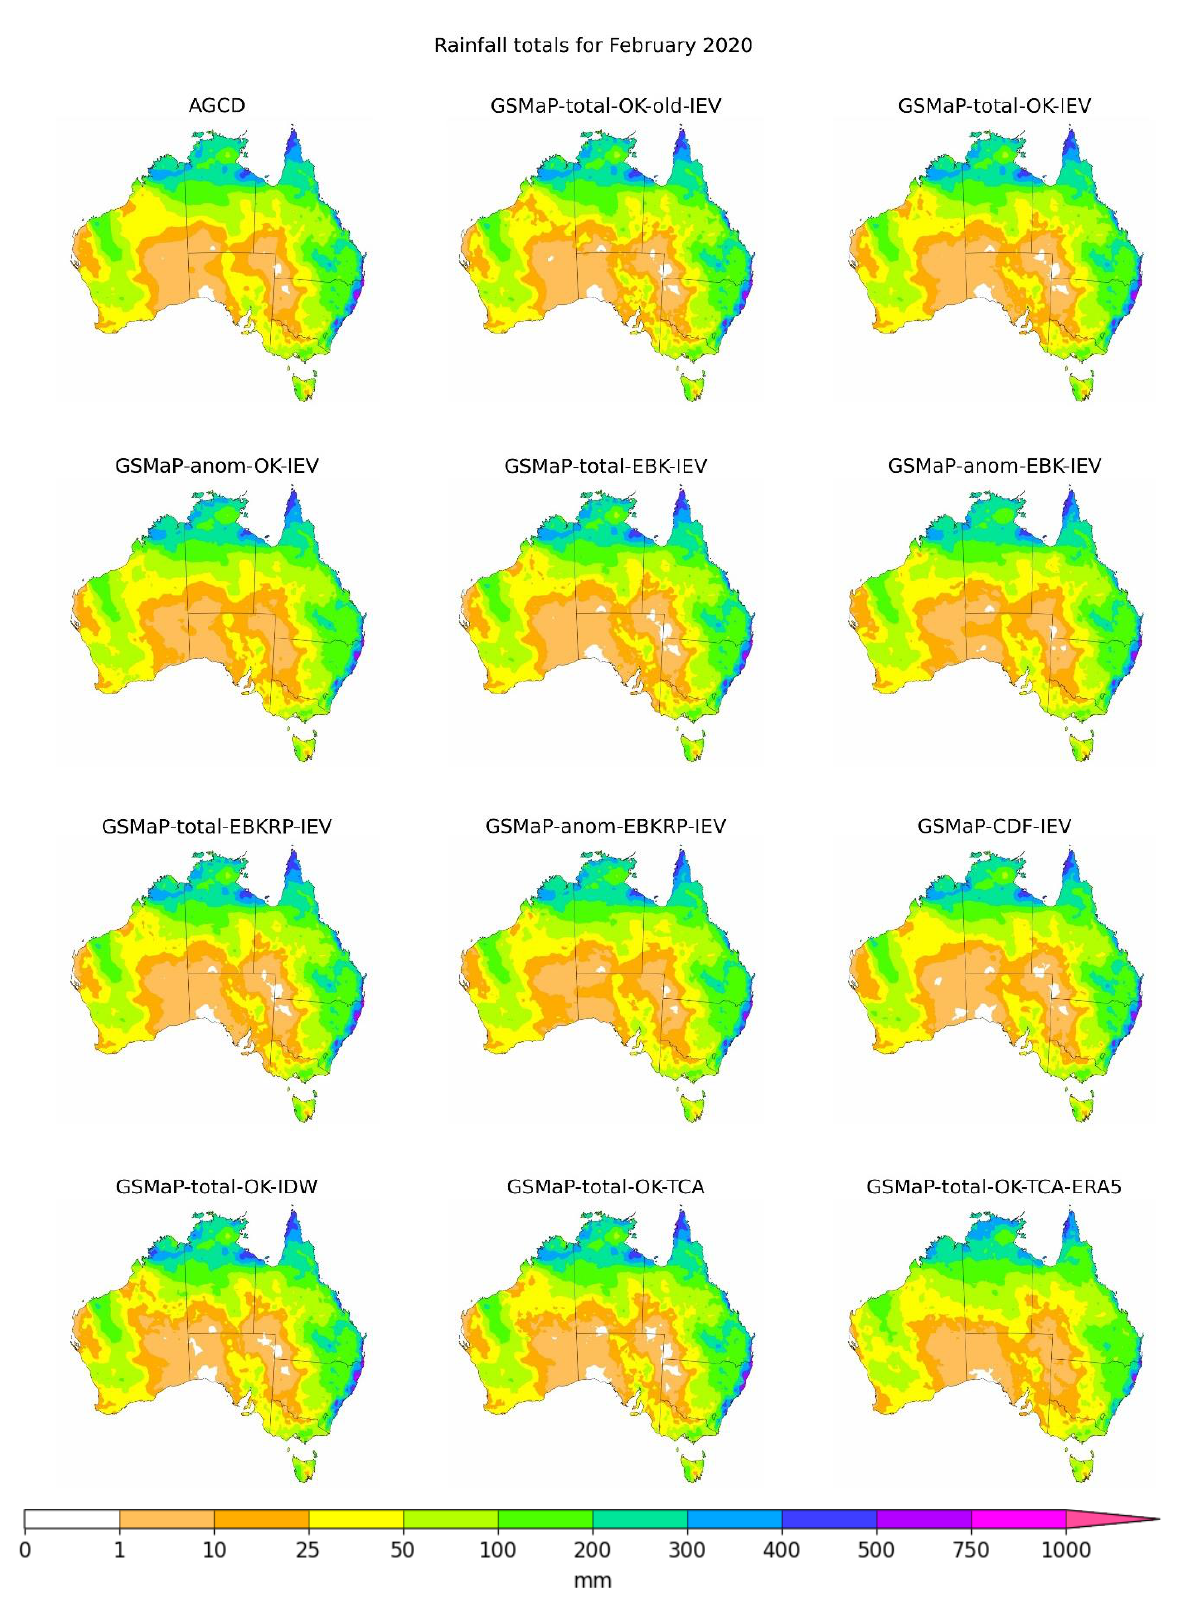
Figure 4. Blended rainfall analyses for February 2020.